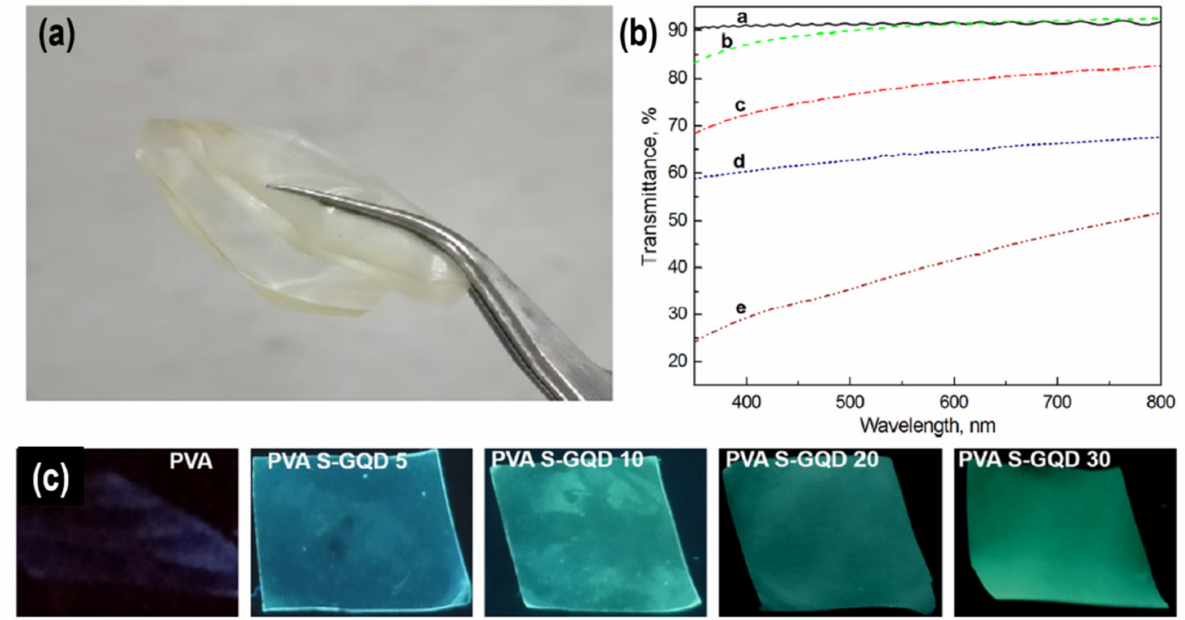
Figure 5. Fabrication of GQD/PVA nanocomposite films. ( a ) Excellent flexibility of the nanocomposite film [77]. ( b ) Optical transparency of (a) PVA film and GQD/PVA nanocomposite film with (b) 3, (c) 5, (d) 15 and (e) 25 wt% GQDs concentration [76]. ( c ) Visual images of nanocomposite films with different SGQDs content